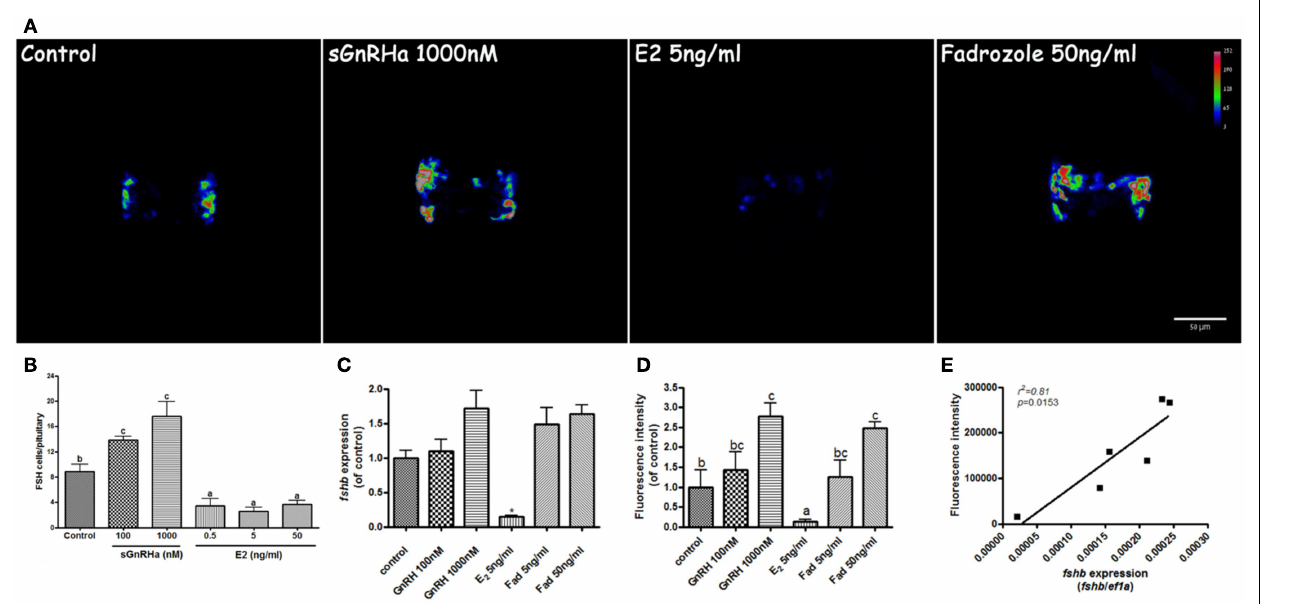
FIGURE 6 | Effect of GnRH and estrogen on fshb and transgene expression . FSH:EGFP larvae at 10days postfertilization were reared for 72h in water containing sGnRHa (100 and 1000nM), 17 β -estradiol (E 2 , 0.5, 5, and 50ng/ml) or the aromatase inhibitor fadrozole (5 and 50ng/ml). (A) Representative heat map of the pituitary of treated fish at the end of the treatment (anterior – up). Color coding corresponds to EGFP signal intensity. GnRH and fadrozole treatment caused an increase in cell number and signal intensity. Estradiol decreased both parameters. (B) Quantification of the